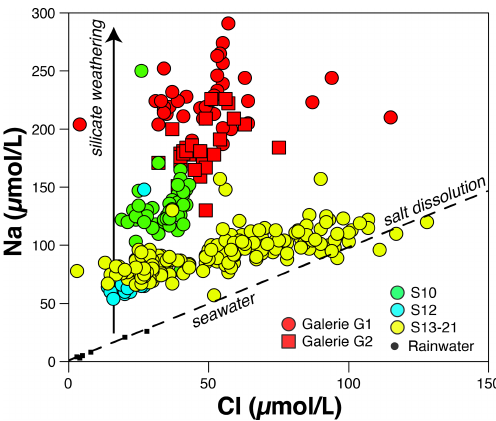
Figure 3. Na vs. Cl concentrations measured in the different groups of water outflow from the Séchilienne massif. Rainwater data points are aligned along the seawater composition (sea